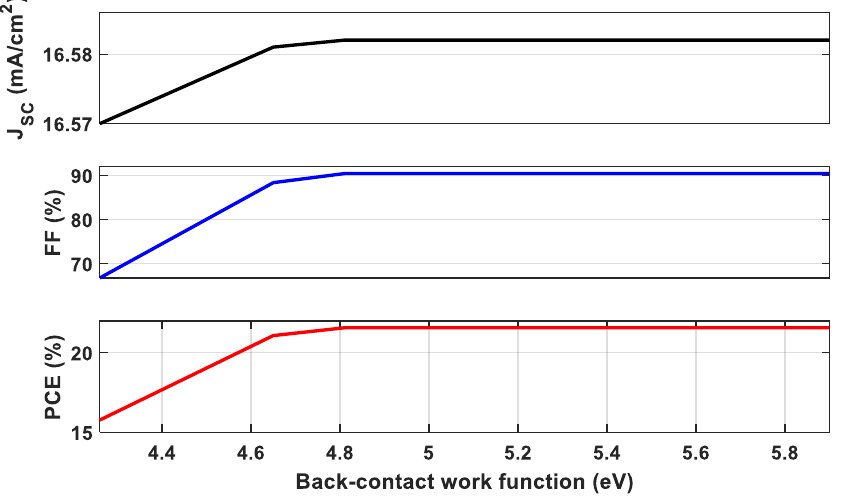
Figure 12. Effect of the work function of different back contact materials on the performance param- eters.